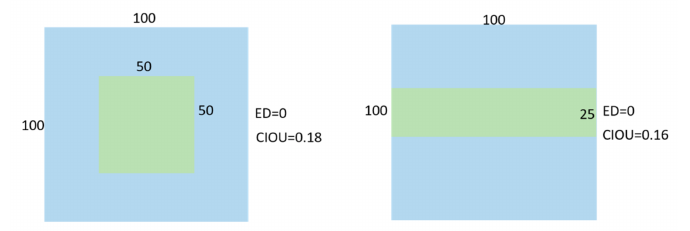
Figure 2. Schematic diagram of the difference between IOU and CIOU